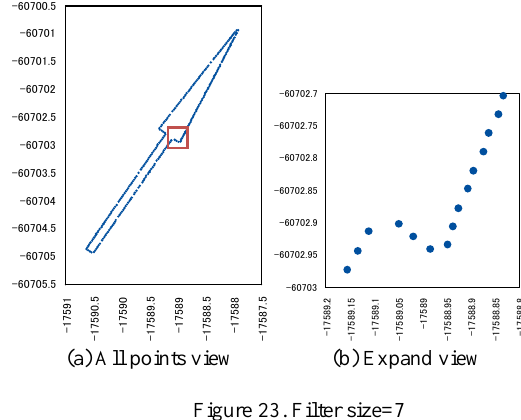
Figure 23. Filter size=7